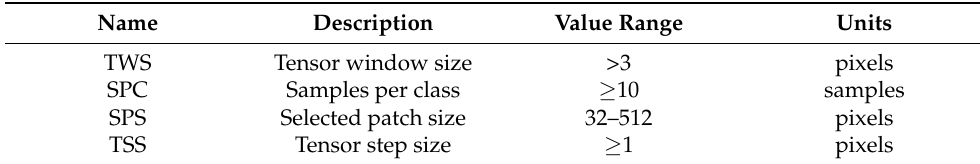
Table 1. The hyper-parameters of the proposed framework.